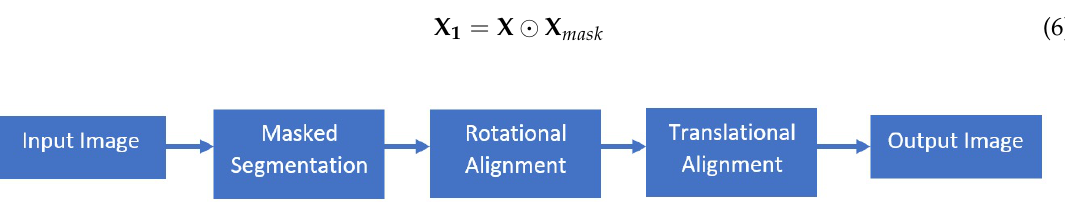
Figure 3. Algorithm flow for the proposed image registration